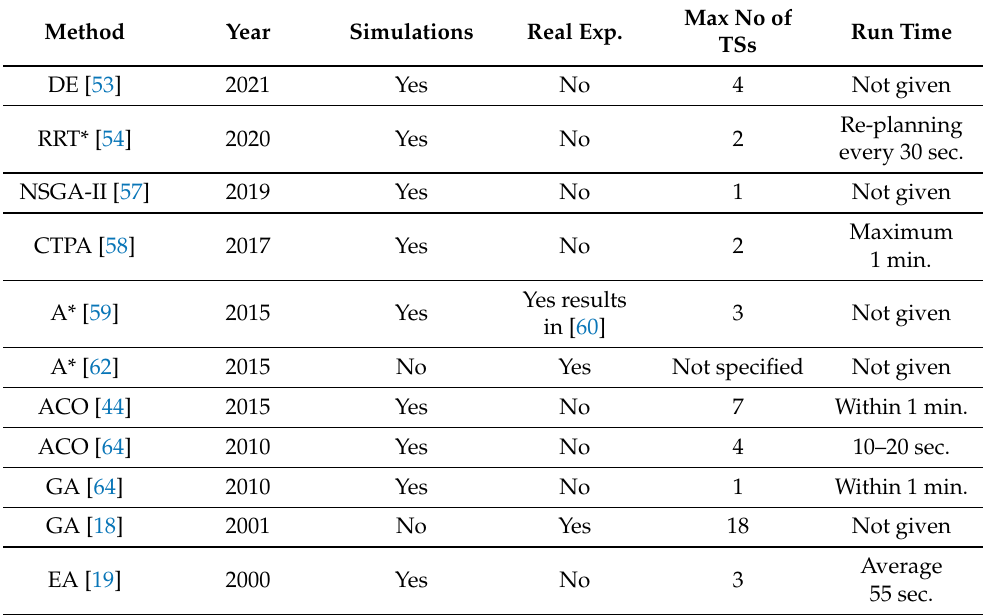
Table 8. A comparison of non-deterministic methods applying radar remote sensing and other sensors—part